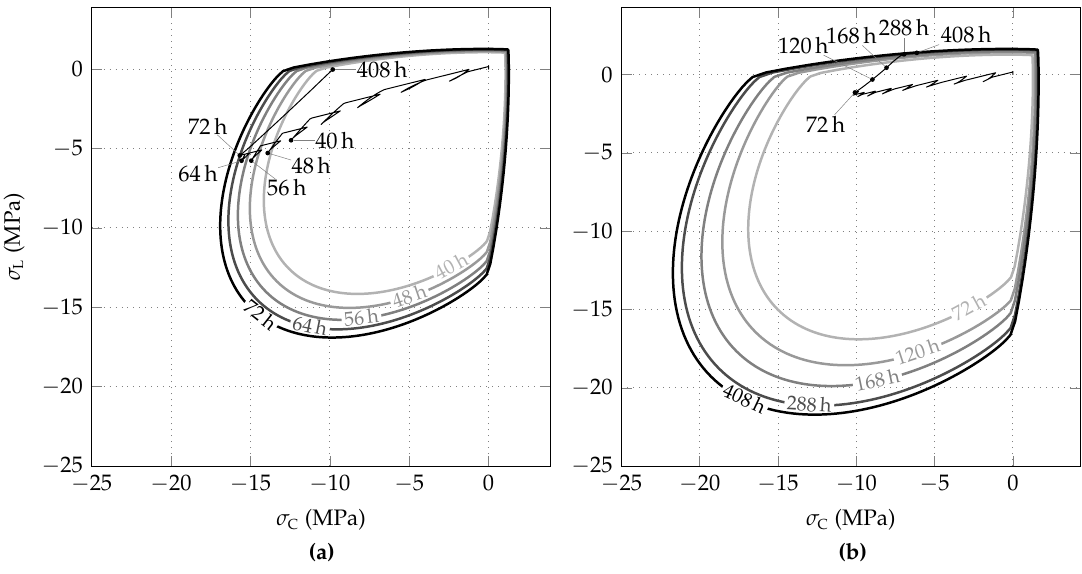
Figure 10. Evolution of biaxial strength envelopes of shotcrete and stress paths, predicted by the SCDP model for initial stress release ratios of ( a ) 85% and ( b ) 95%.